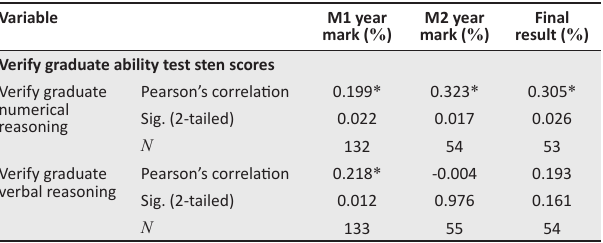
TABLE 5: Pearson’s correlation between academic success and to verify graduate ability tests (verbal and numerical).